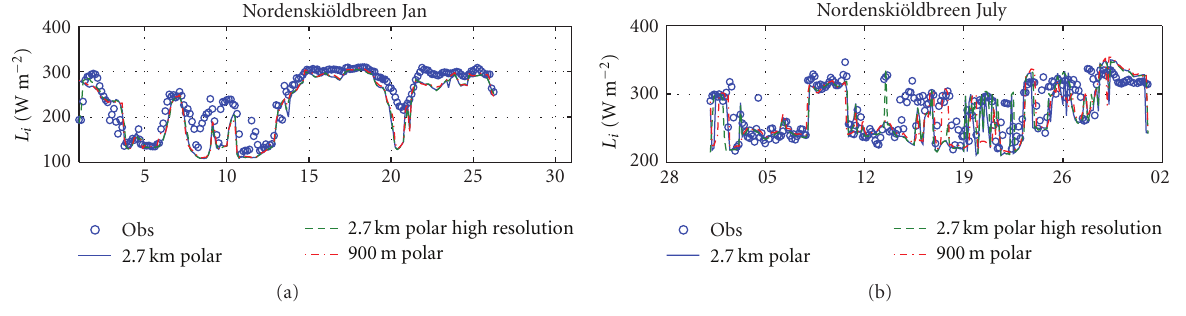
Figure 12: Time series of incoming long-wave radiation at Nordenski¨oldbreen.